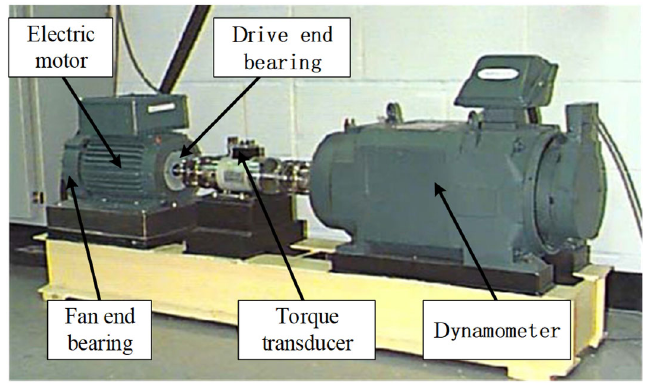
Figure 8. Bearing fault test platform [37].